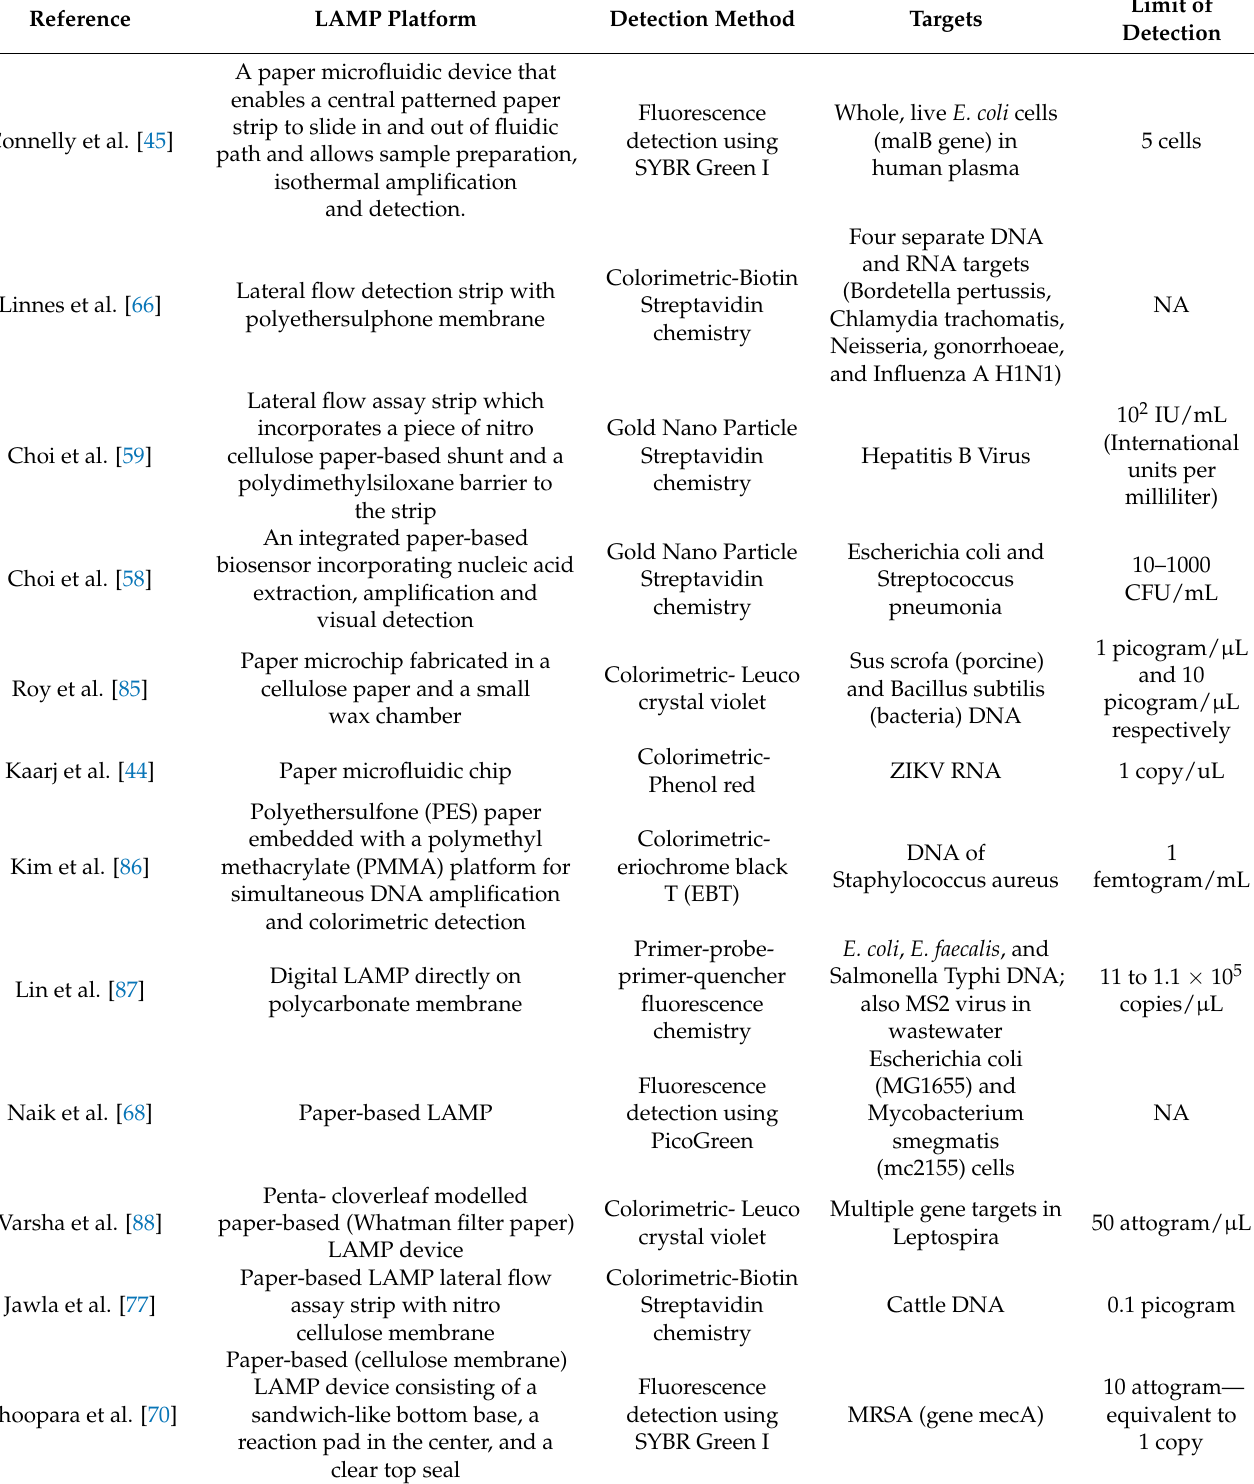
Table 3. Paper-based LAMP platforms, targets, detection methods and limit of